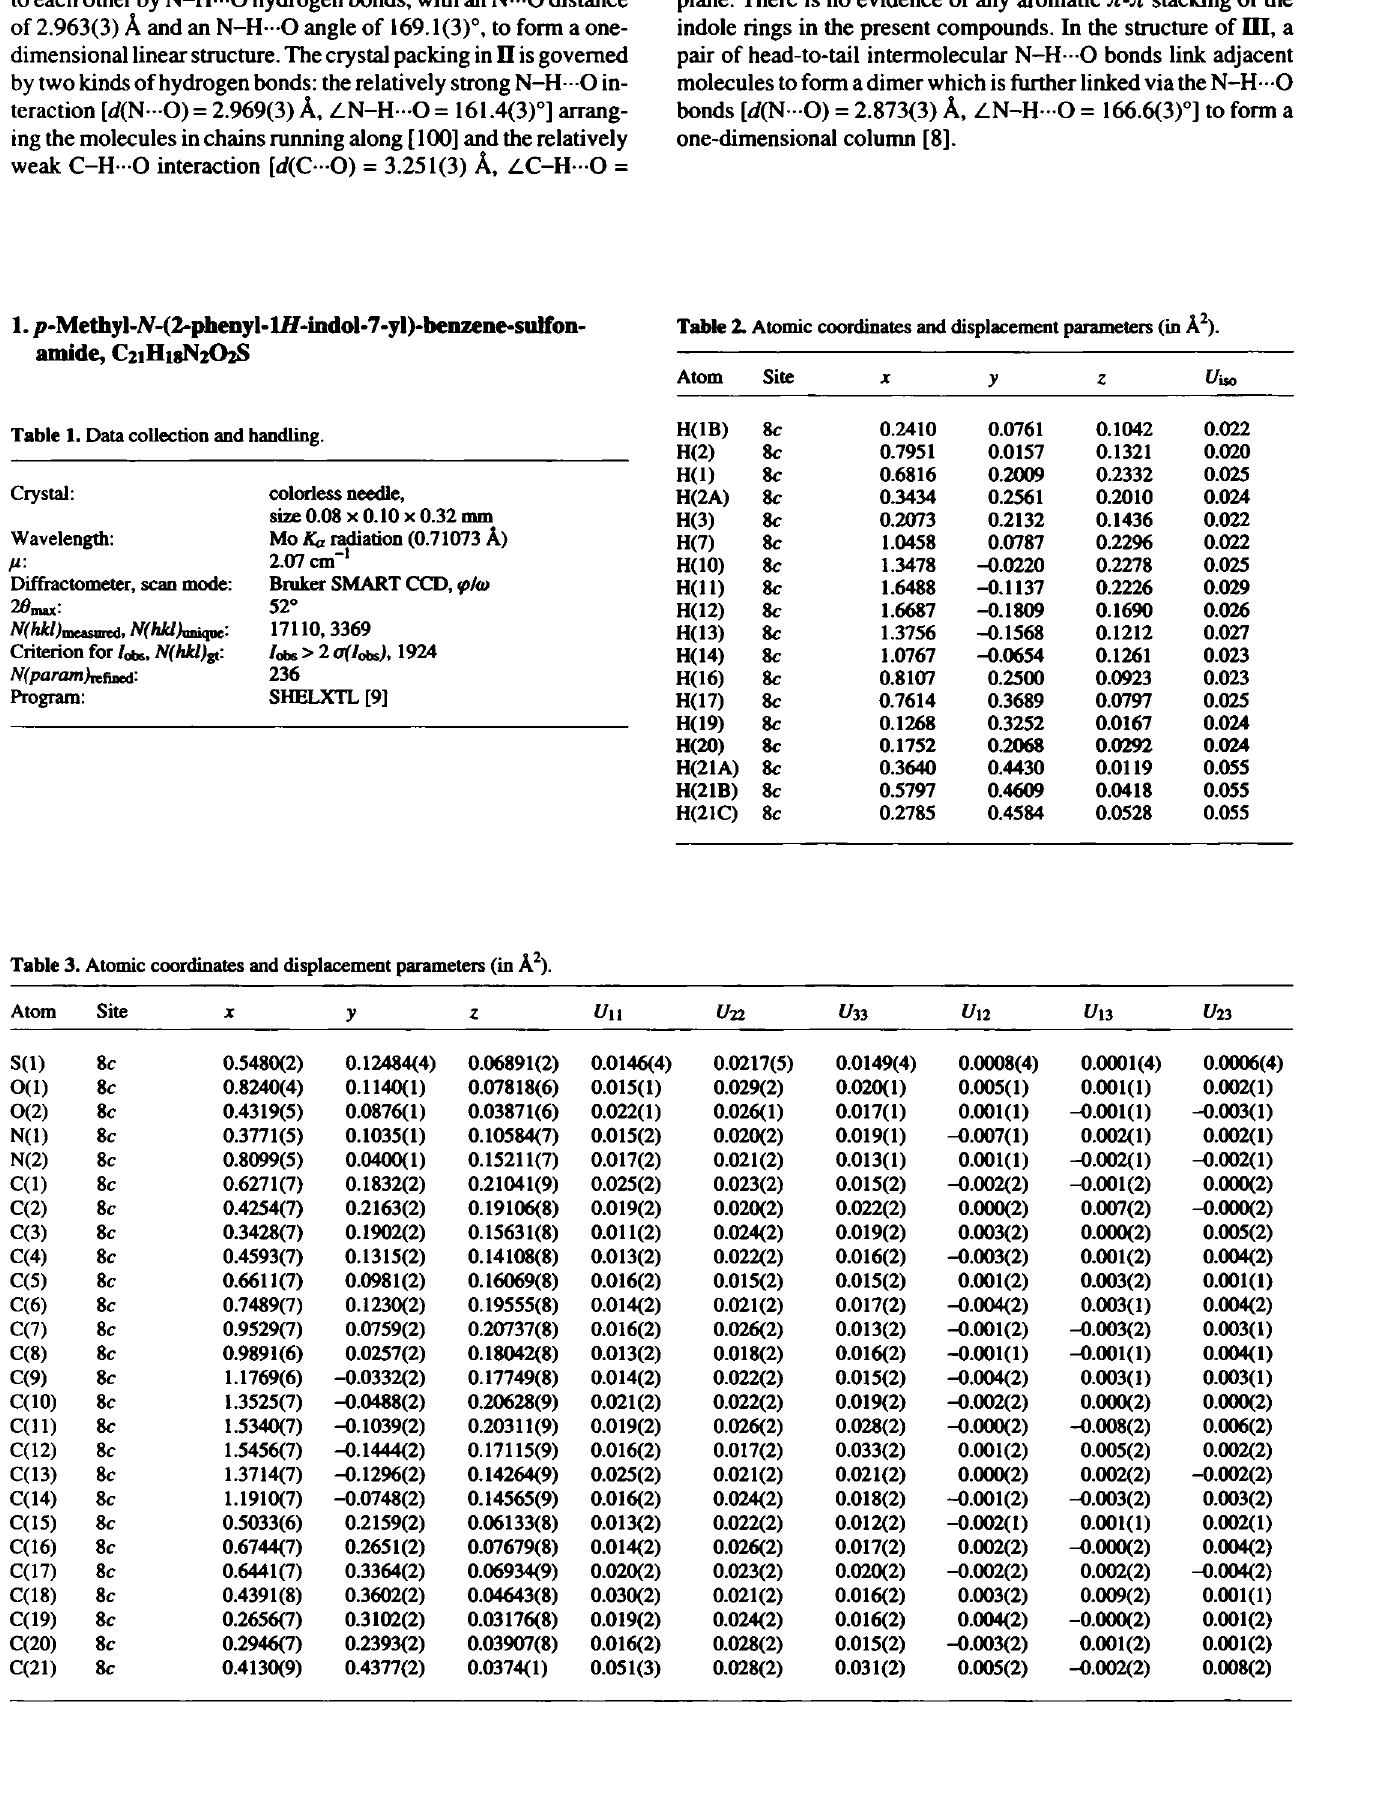
Table 3. Atomic coordinates and displacement parameters (in A 2